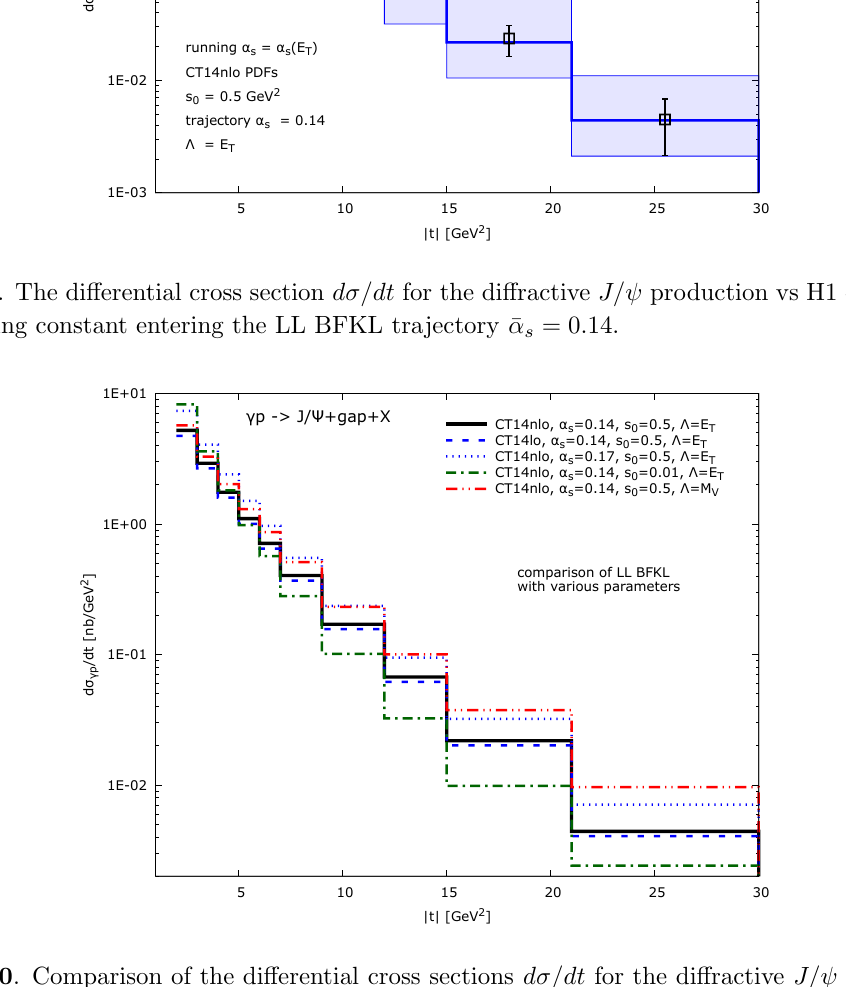
Figure 10 . Comparison of the differential cross sections dσ/dt for the diffractive J/ψ production for some configurations of the model